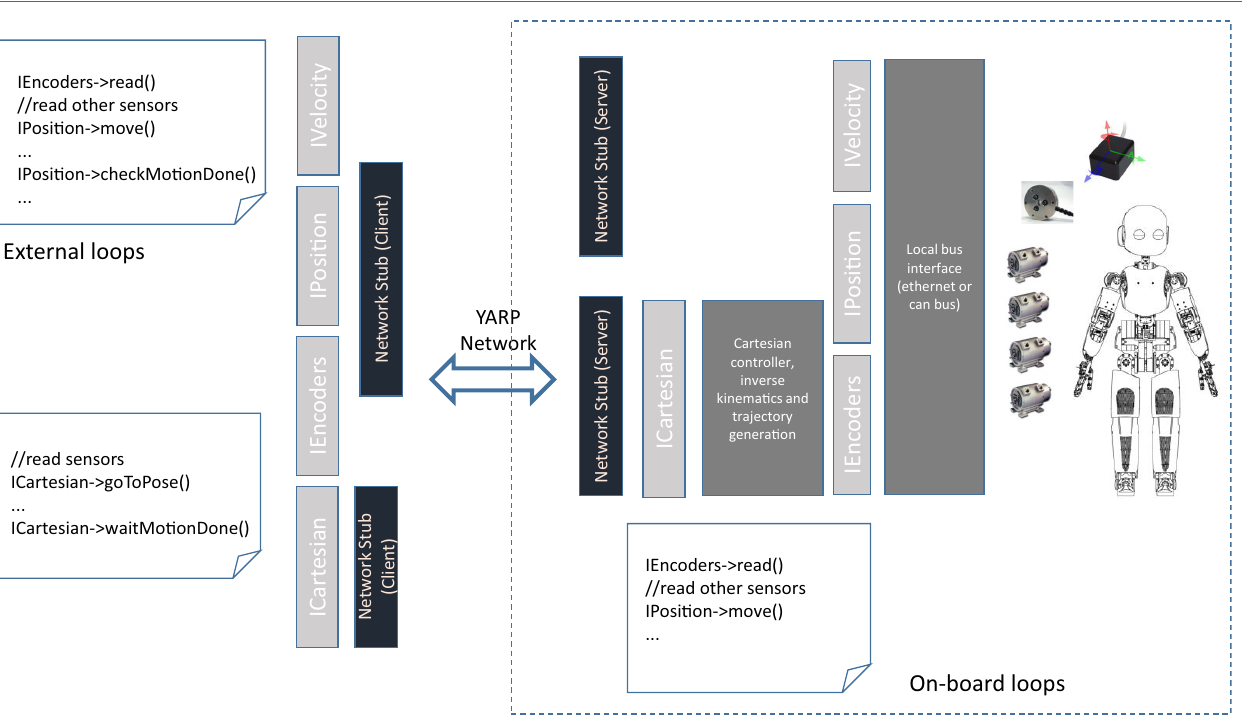
FigUre 5 | interfaces to the robot . User-level drivers communicate to the hardware using device drivers. These objects (dark gray) implement a set of standard interfaces (light gray) for reading sensors and controlling the motors at the joint level. Other controllers can be connected ( via an action called attach ) to these drivers to implement control loops (like for example Cartesian control of the limbs). Special network stubs (black) export the functionalities of the drivers through the YARP network and allow users to execute control loops externally to the robot. To do so, the user instantiates clients network stubs that implement the same interfaces by dispatching requests through the network using YARP Ports . These messages are received by the remote servers, which translate messages via function call to the hardware device using the user drivers. If needed, the server also takes care of preparing the reply and sending it to the client, which, finally, returns control to the user